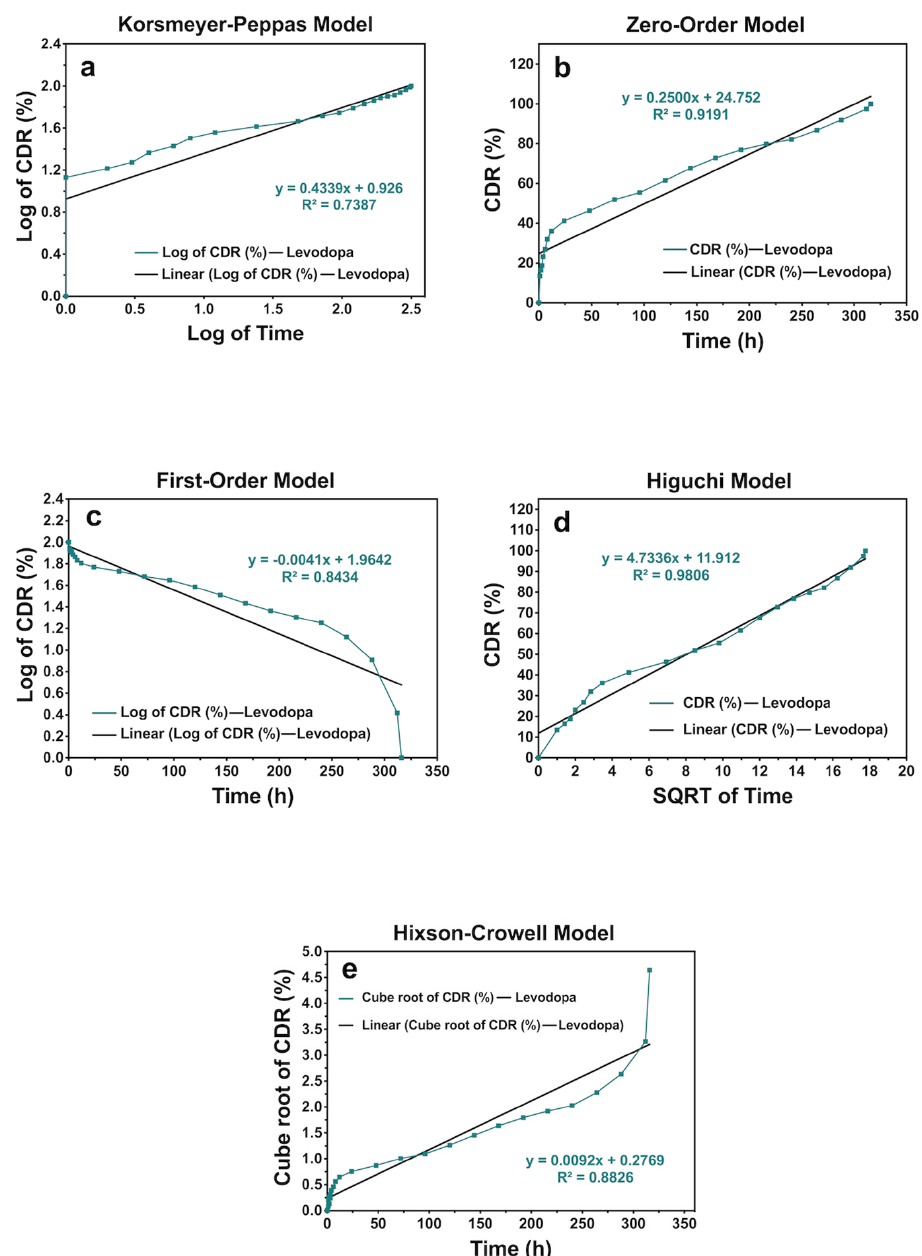
Figure 6. The release kinetic models of levodopa release profiles from the scaffolds that have the concentration of levodopa at 0.01 mg/mL for 336 h: ( a ) Korsmeyer–Peppas, ( b ) zero-order, ( c ) first- order, ( d ) Higuchi, and ( e ) Hixson–Crowell models.